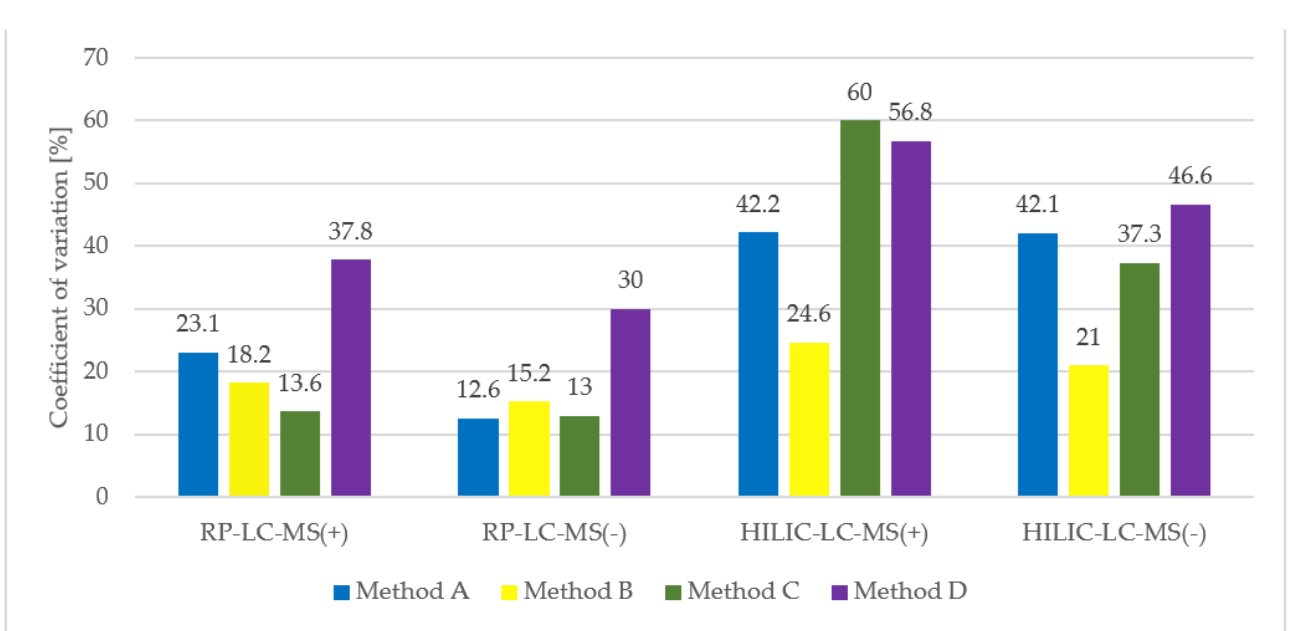
Figure 7. UpSet plots presenting the overlap between compared extraction methods in terms of polar compounds detected in ( A ) positive and ( B ) negative MS ionization modes.